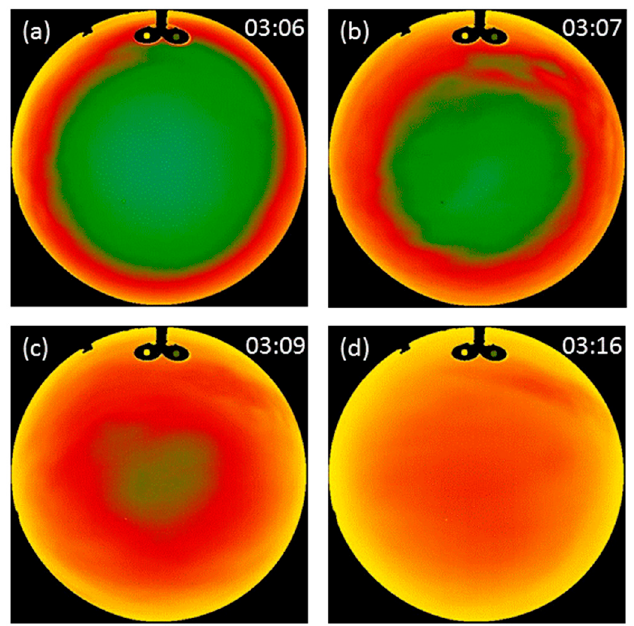
Figure 6. Sky image at 4 January 2021. ( a ) 03:06—the fog is low and the whole sky image is clear. ( b ) 03:07—the fog is rising rapidly as indicated by the increased brightness temperature of the sky at low elevation angles. ( c ) 03:09—the fog continues to rise, but the clear sky is still present near the zenith. ( d ) 03:16—the fog covers the entire sensor’s field of view, but not very densely, as the sky image is not completely homogenous.